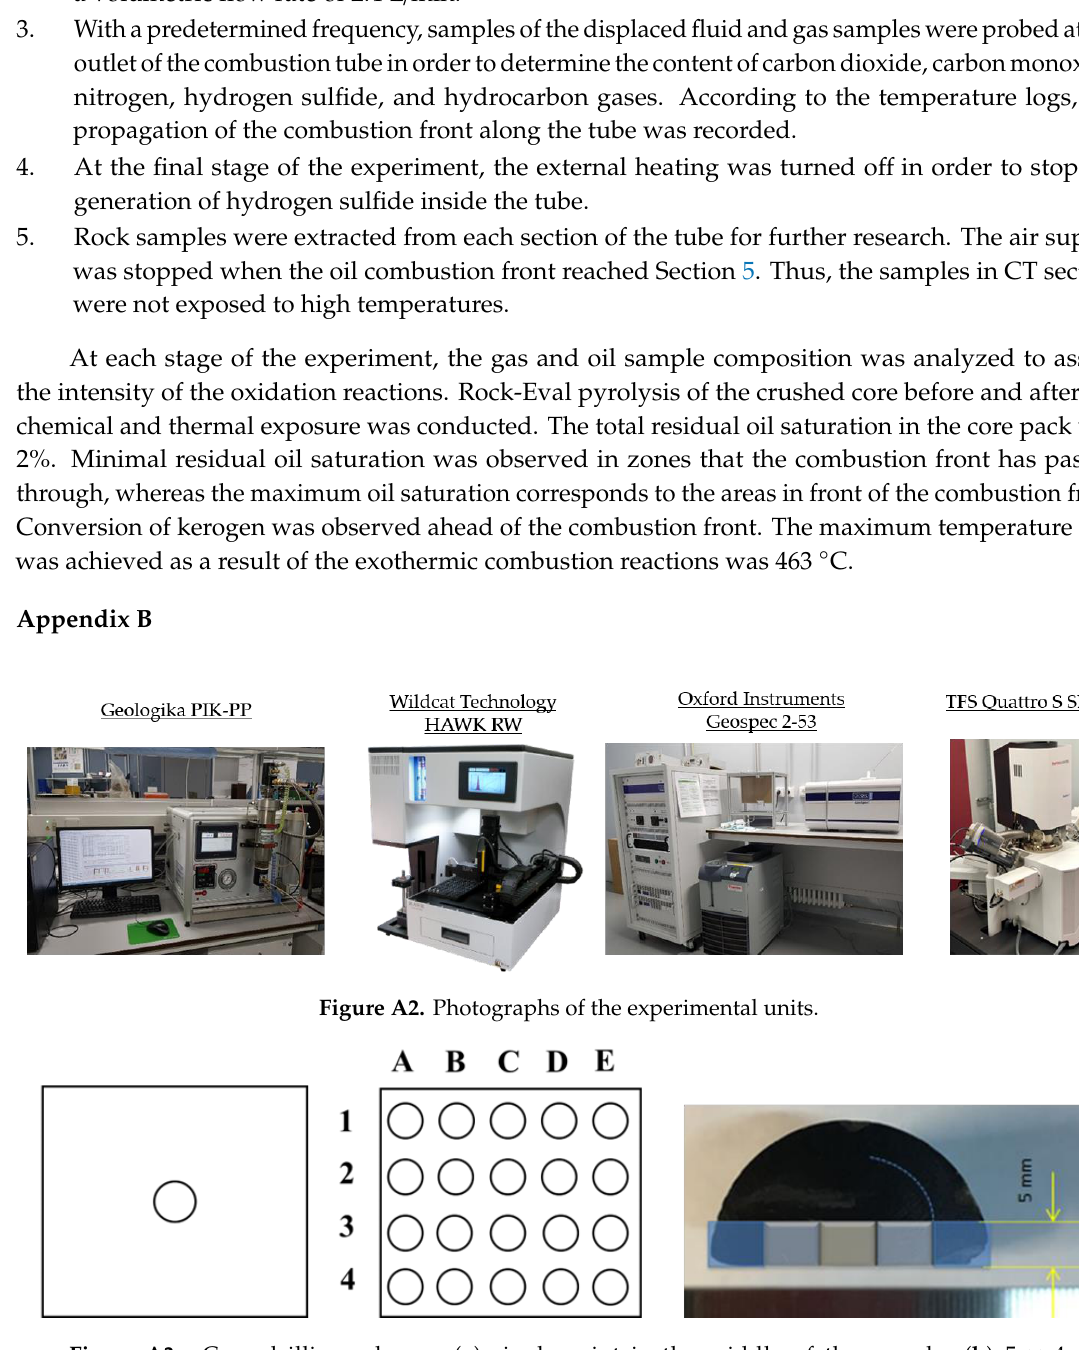
Figure A3. Core drilling schemes ( a ) single-point in the middle of the sample; ( b ) 5 × 4; ( c ) drilling